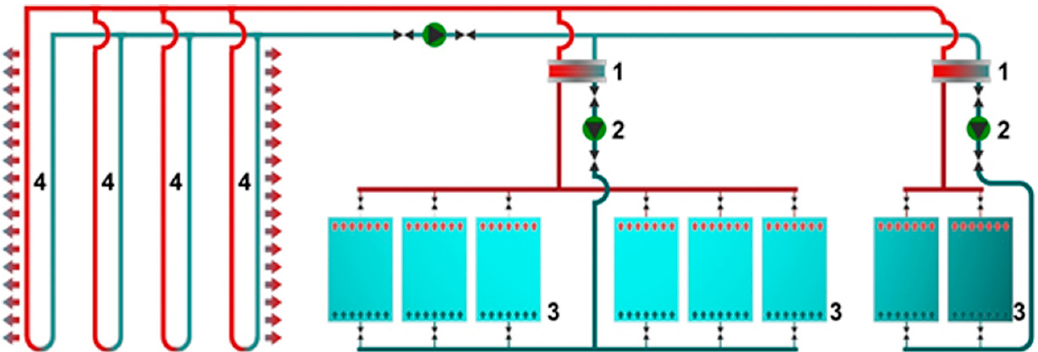
Figure 1. Schematics of the energy system. 1. Plate heat exchangers, 2. Water circulation pumps and